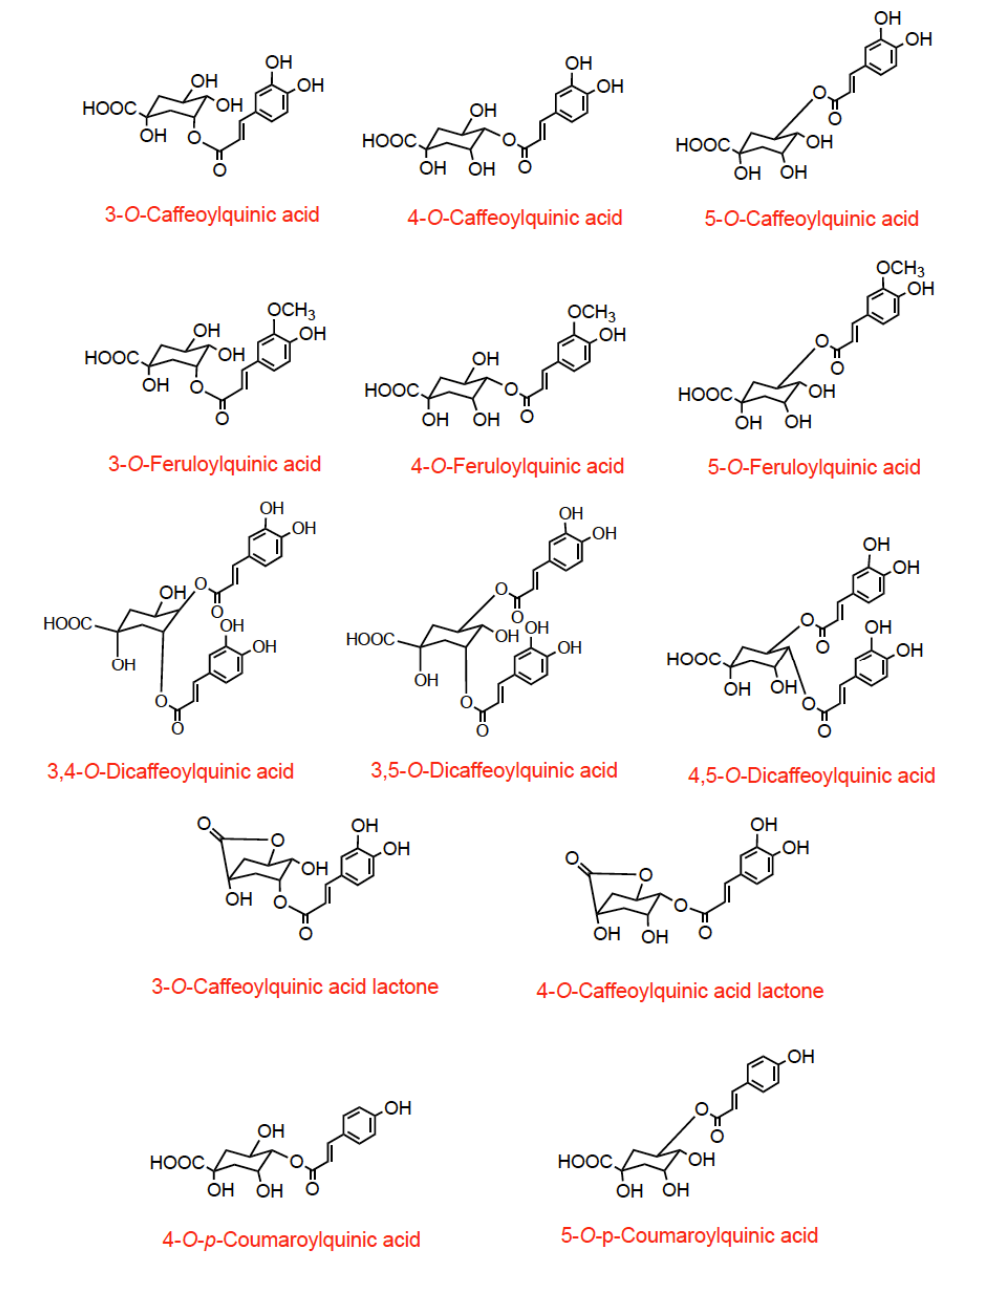
Figure 1 . Structures of chlorogenic acids occurring in